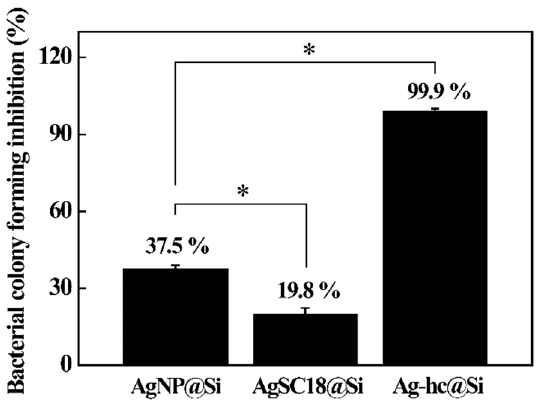
Figure 5. Bacterial colony forming inhibition (%) of AgNP@Si, AgSC18@Si, and Ag-hc@Si for